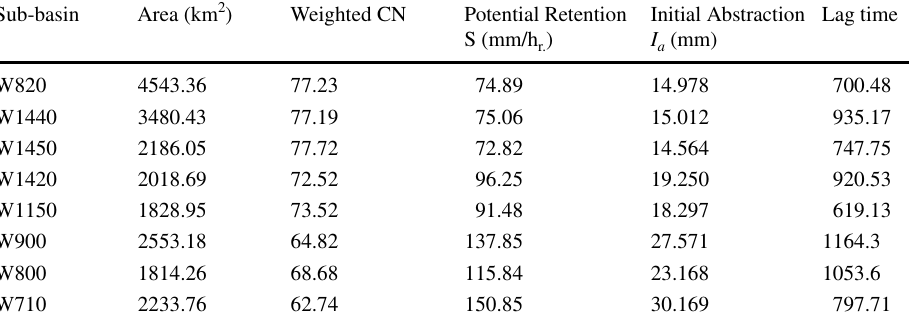
Table 4 SCS CN Method Initial